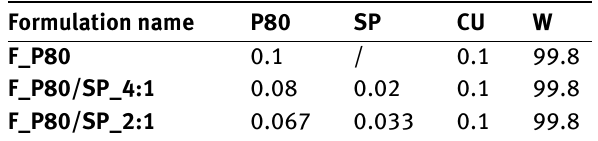
Table 2: Qualitative and quantitative (%) composition of selected nanosuspensions Formulation